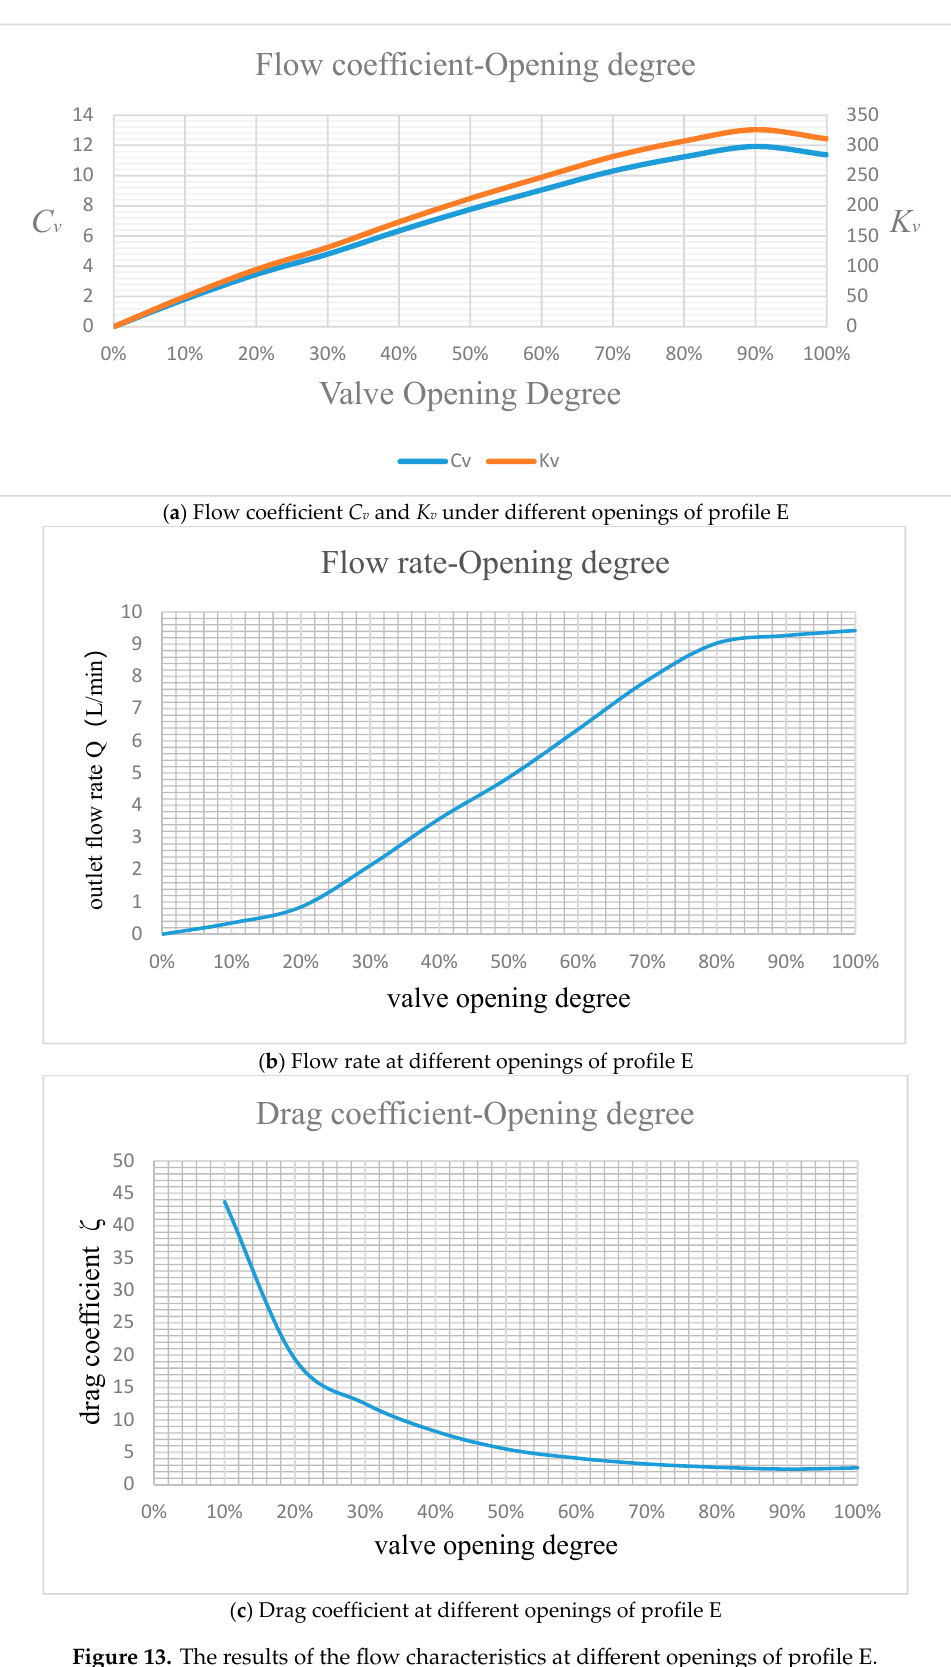
Figure 13. The results of the flow characteristics at different openings of profile E.